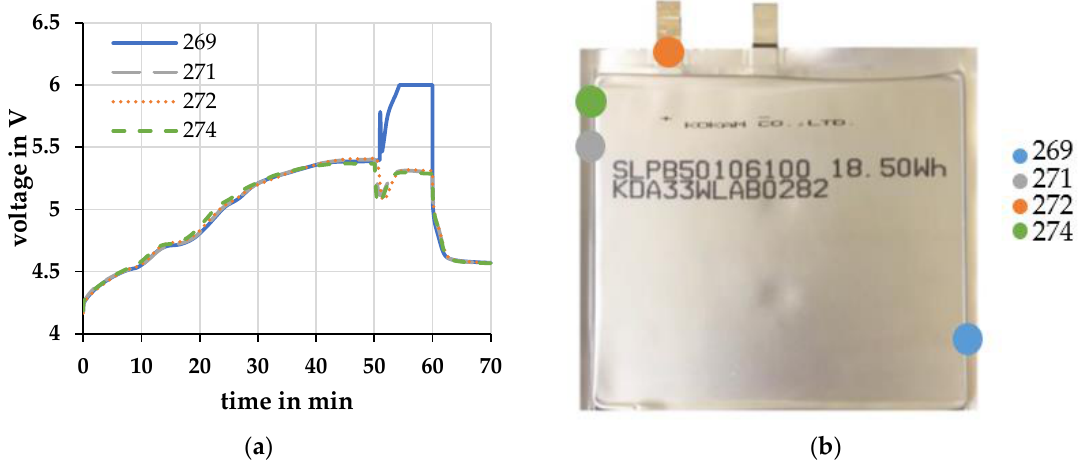
Figure 2. ( a ) Voltage profiles of different cells at a charging current of 1C and an ambient temperature of 20 °C ± 2 °C; ( b ) Opening points of the cells during overcharge.